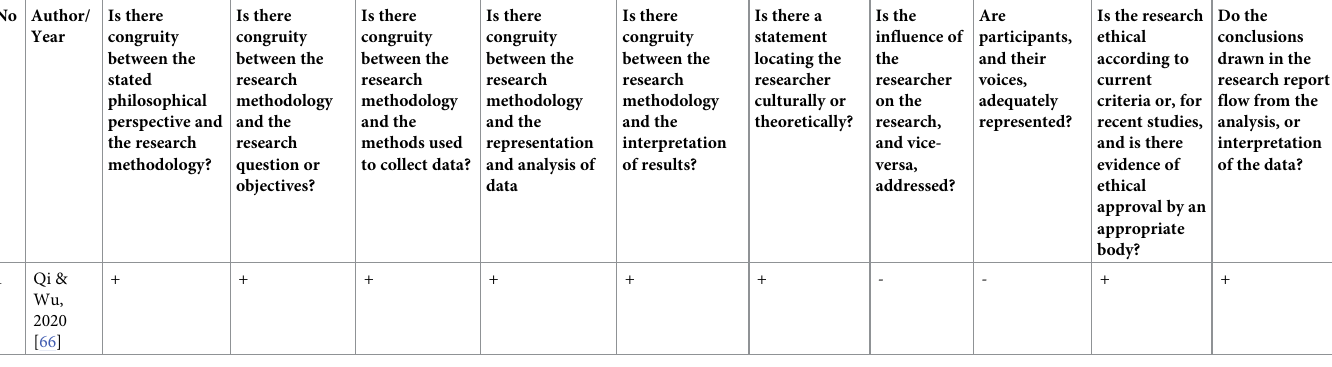
Table 3 the positive (+) sign illustrates, Yes, and the negative (-) sign indicates No.